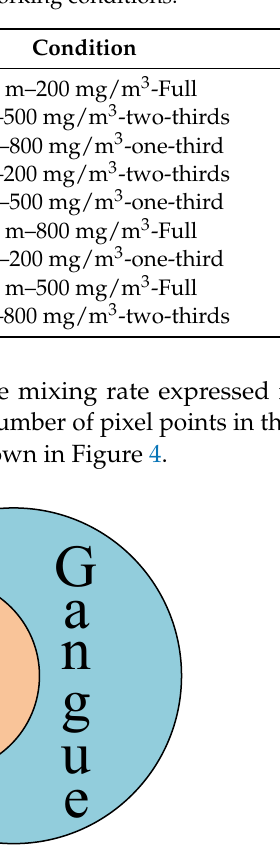
Table 3. Nine working conditions.